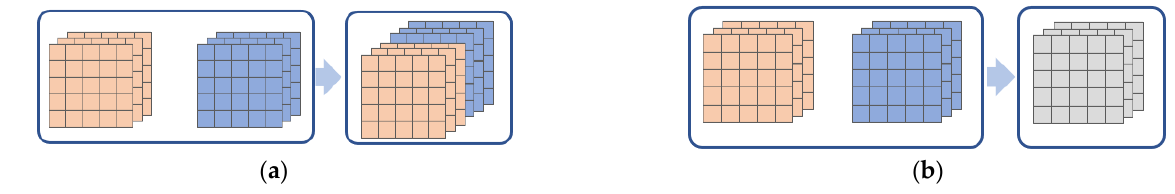
Figure 9. Method of feature fusion: ( a ) feature cascade; ( b ) feature element-wise sum.